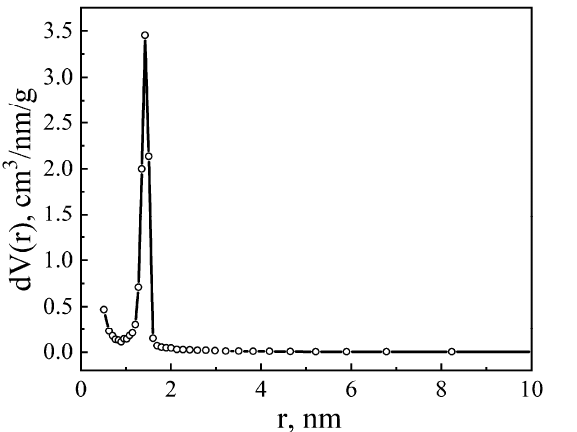
Figure 1. Distribution of pores in MSM-41 according to the adsorption branch of the isotherm, according to the BET method.